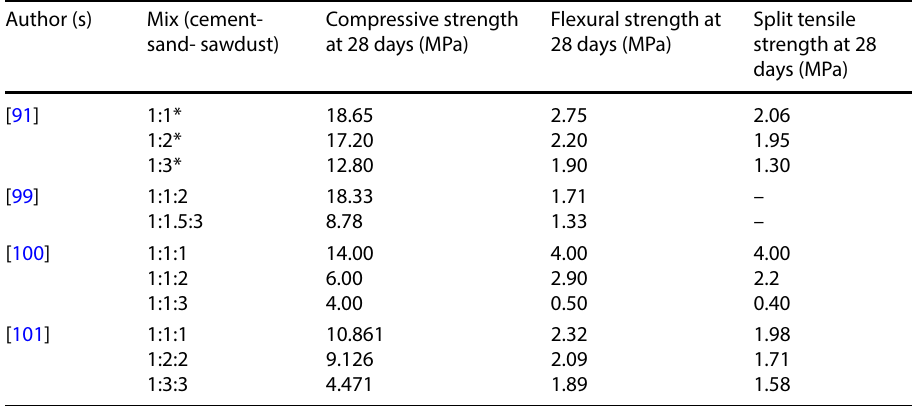
Table 5 Strengths of various sawdust mix composites, including their compressive, flexural, and split tensile properties